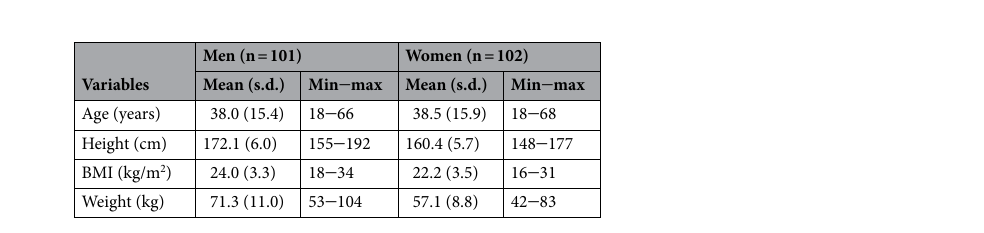
Table 1. Physical characteristics of the subjects. s.d. standard deviation, BMI body mass index.